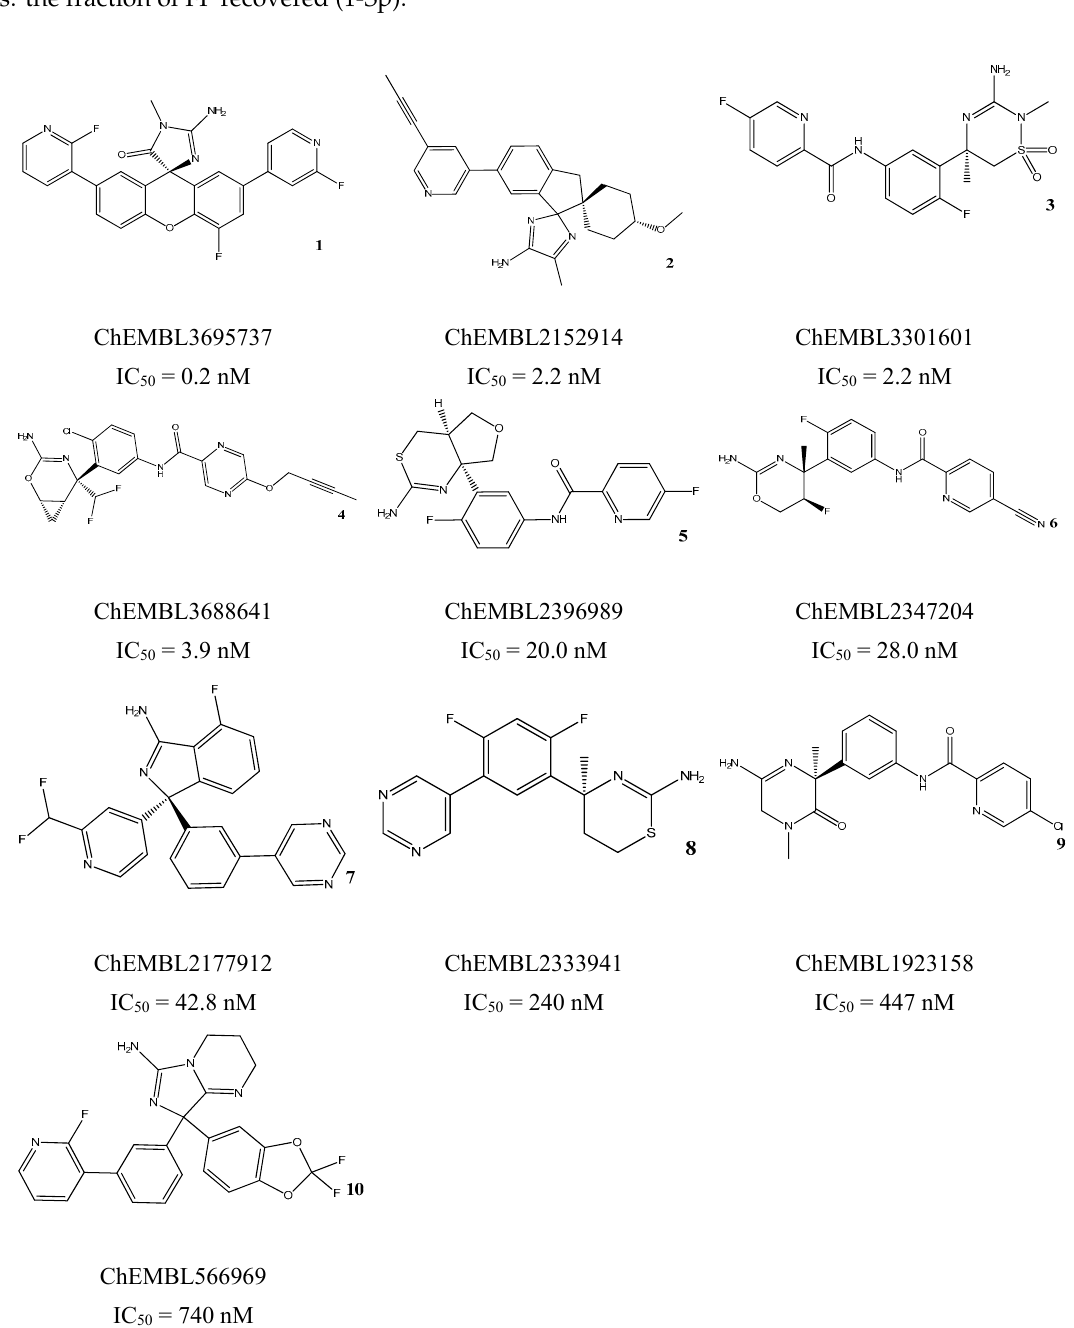
Figure 2. Chemical structures of the Training set used for mapping of consensus pharmacophoric features for the ligand-based (LB) approach with an activity range (IC 50 value) from 0.2 nM to 740 nM.